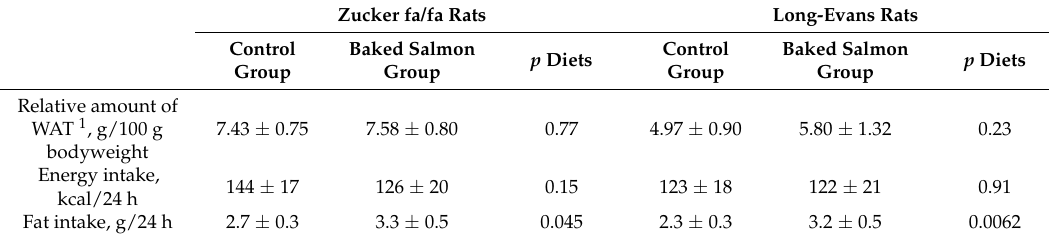
Table 3. Relative weight of WAT, energy intake, and fat intake is a table.